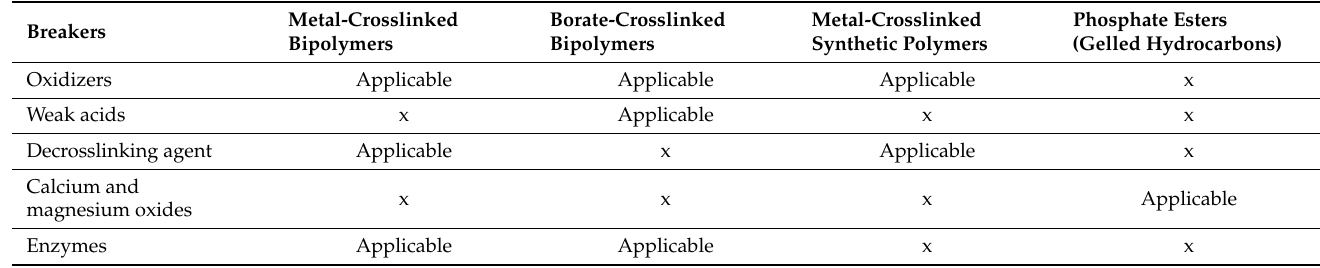
Table 2. Breaker